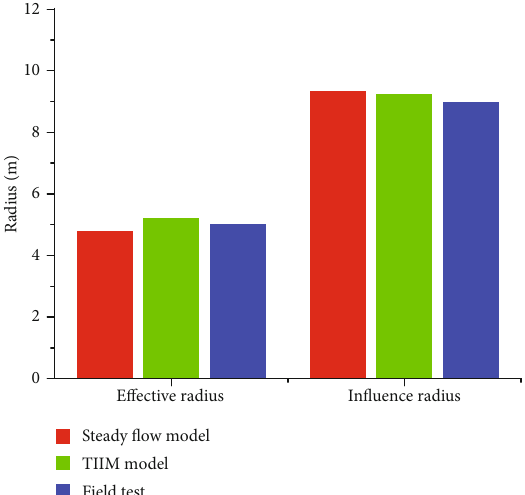
Figure 6: E ff ective radius and in fl uence radius of methane extraction obtained from the steady fl ow model, THM coupling model, and fi eld